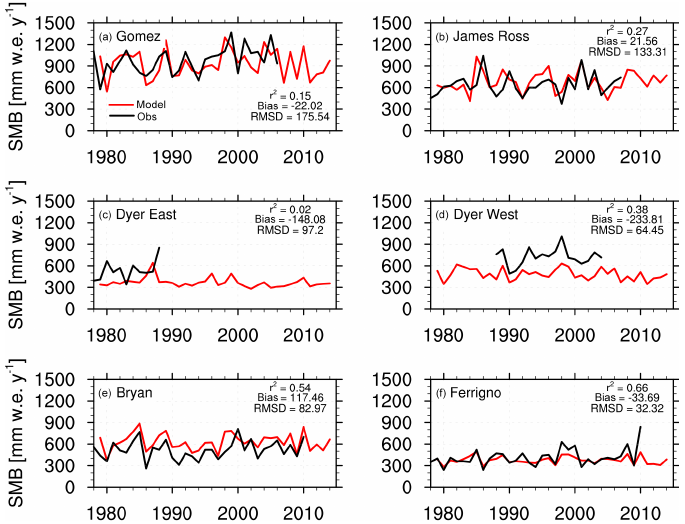
Figure 4. Modelled and observed yearly (1979–2014) SMB (mmweyr − 1 ) at locations of Gomez ( a , 73 ◦ S, 70 ◦ W), James Ross Island ( b , 64.12 ◦ S, 57.54 ◦ W), Dyer Plateau East ( c , 70.4 ◦ S, 64.5 ◦ W), Dyer Plateau West ( d , 70.7 ◦ S, 64.9 ◦ W), Bryan Coast ( e , 74.3 ◦ S, 81.4 ◦ W) and Ferrigno ( f , 74.3 ◦ S, 86.5 ◦ W) ice core sites. Statistics ( r 2 , bias and RMSD) are also given. Ice core locations are shown in Figs. 1 and